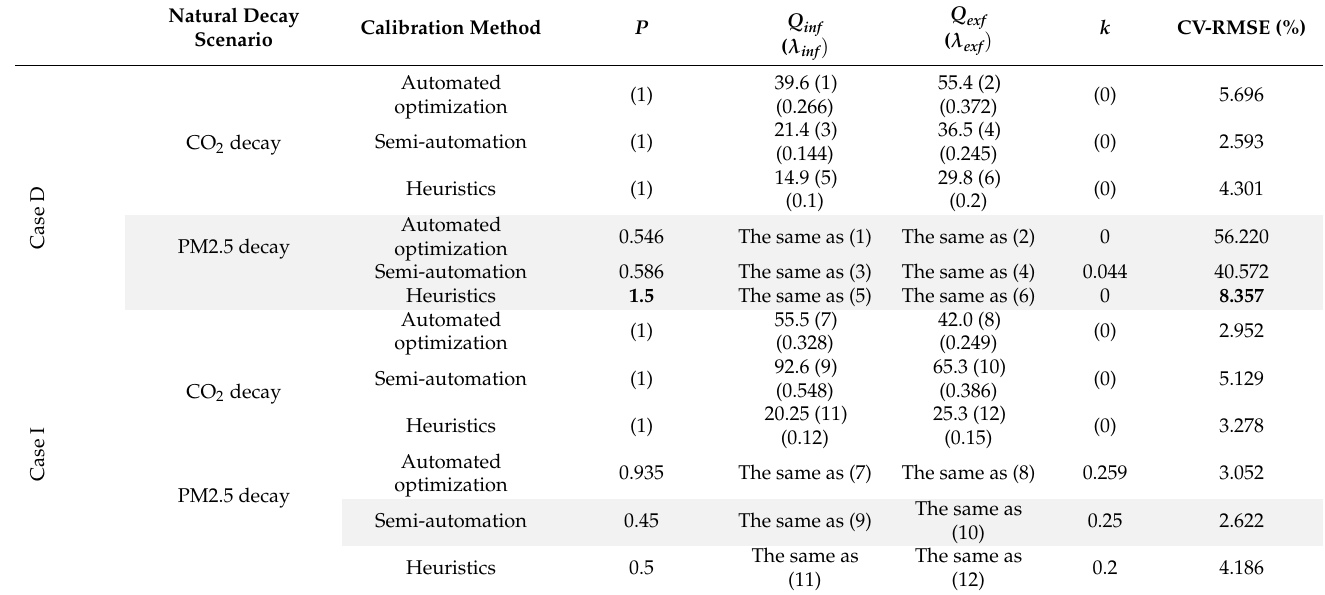
Table 3. Estimated values of the control variables for natural decay scenarios.